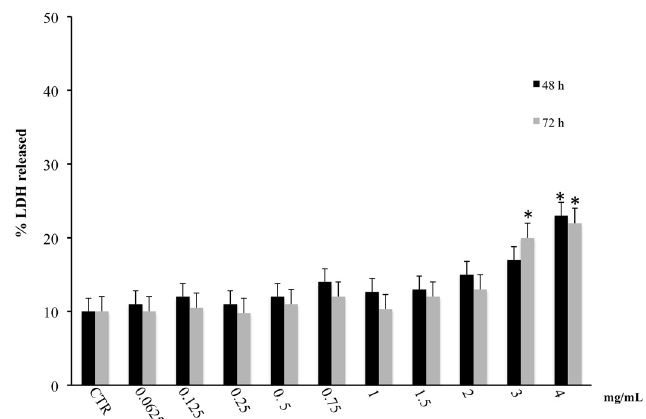
Figure 2. LDH released in CaCo2 cells untreated and treated for 48 and 72 h with the hydroalcoholic extract of M. incana aerial parts. Values are the mean ± SD of four experiments in triplicate. * Significant vs. untreated control cells: p < 0.001.